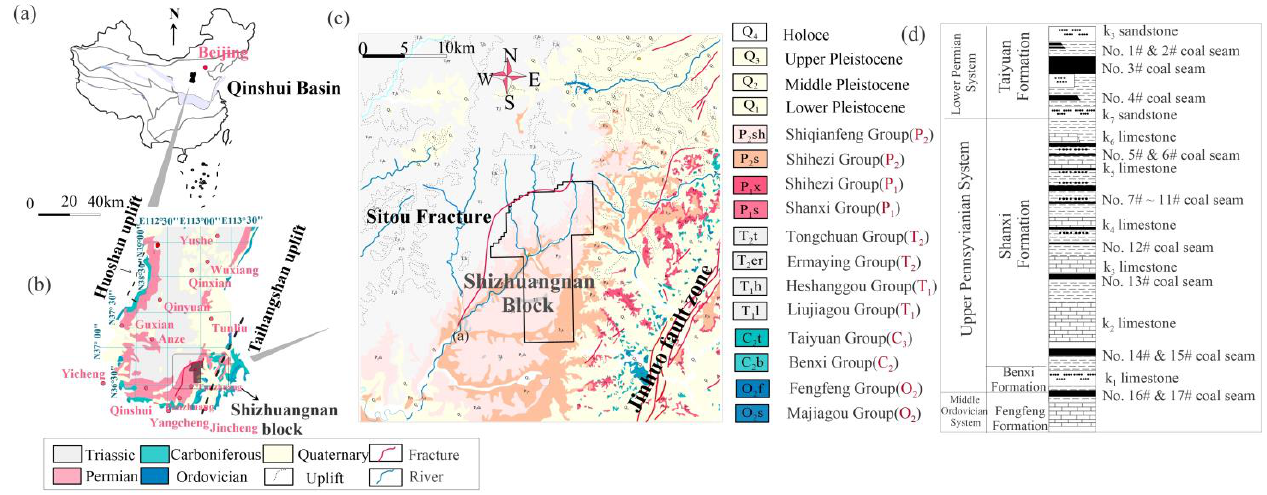
Figure 1. Comprehensive geological map of the study area: ( a ) location of Qinshui Basin in China; ( b ) geological map of exposed strata and location of the Shizhuangnan block in the southern Qinshui Basin; ( c ) geological map of exposed strata in the Shizhuangnan block; ( d ) stratigraphic column of the study area.